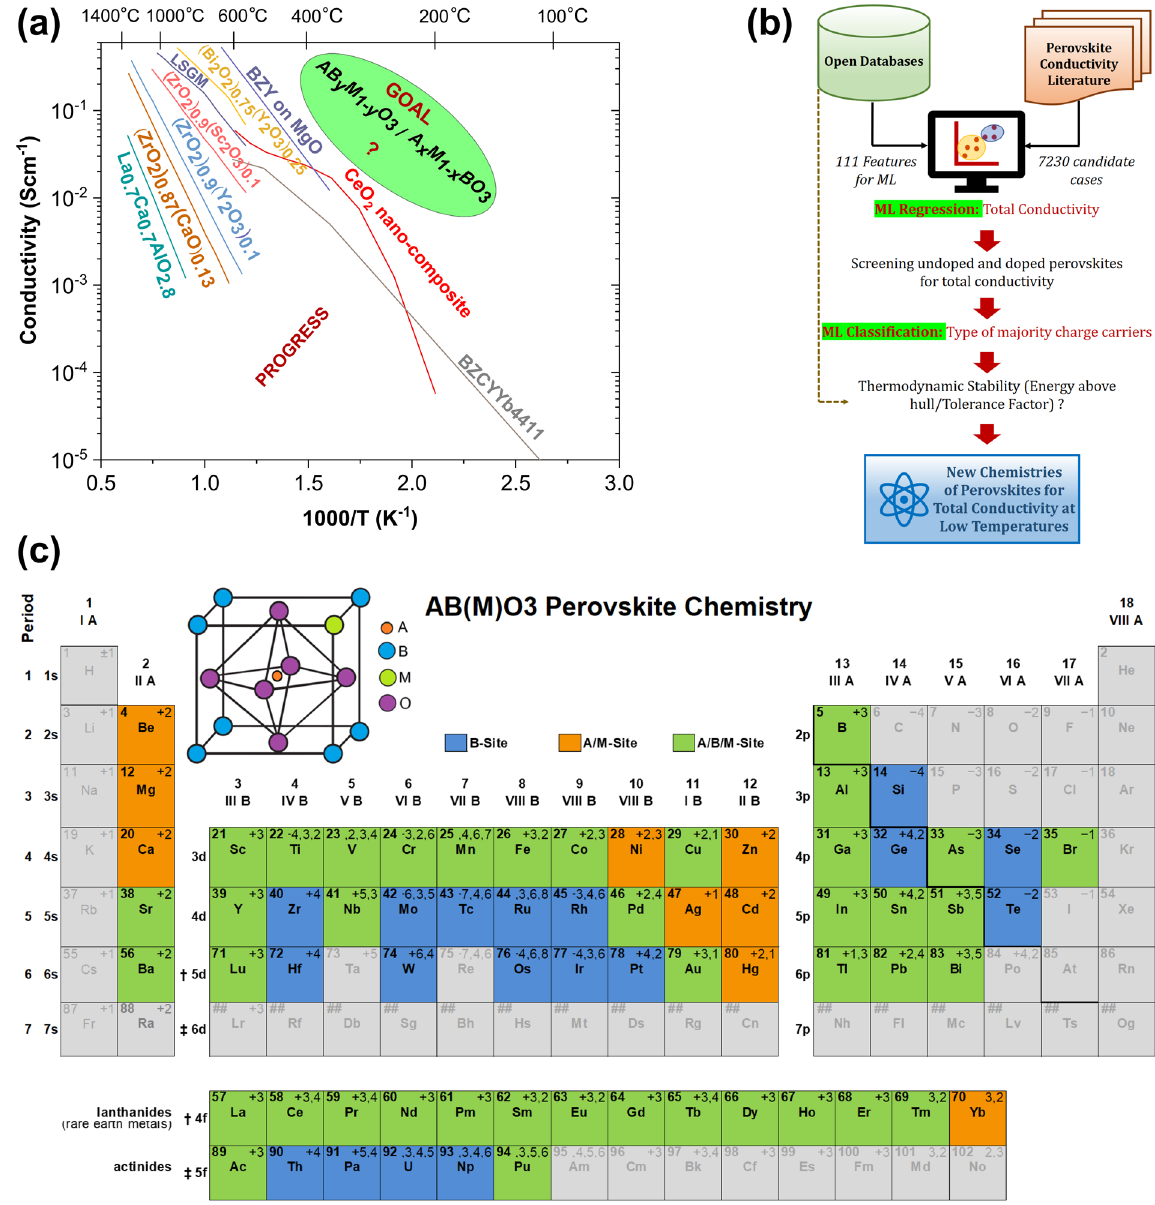
learning (ML). b The fl ow chart for the methodology adopted in this work. Total conductivity and charge carrier data from literature and 111 features from open databases are used to train a regressor ML model for total conductivity, to screen perovskites for high conductivities. These are then tested for stability based on energy above hull and tolerance factor. The stable perovskites are then classi fi ed for majority charge carrier using the charge carrier data from literature and 112 features ( + total conductivity), resulting in the prediction of new perovskite chemistries for different charge carriers. c Periodic table 118 (adapted) showing the complexity of screened perovskite (ABO 3 ) chemistries for conductivity. All the A, B, and M (which is A- or B-site dopant) elements considered are shown. The elements have been chosen depending on the stability for AO and A 2 O 3 type oxides and BO 2 and B 2 O 3 type oxides for type I (AO + BO 2 ) and type II (A 2 O 3 + B 2 O 3 ) perovskites with